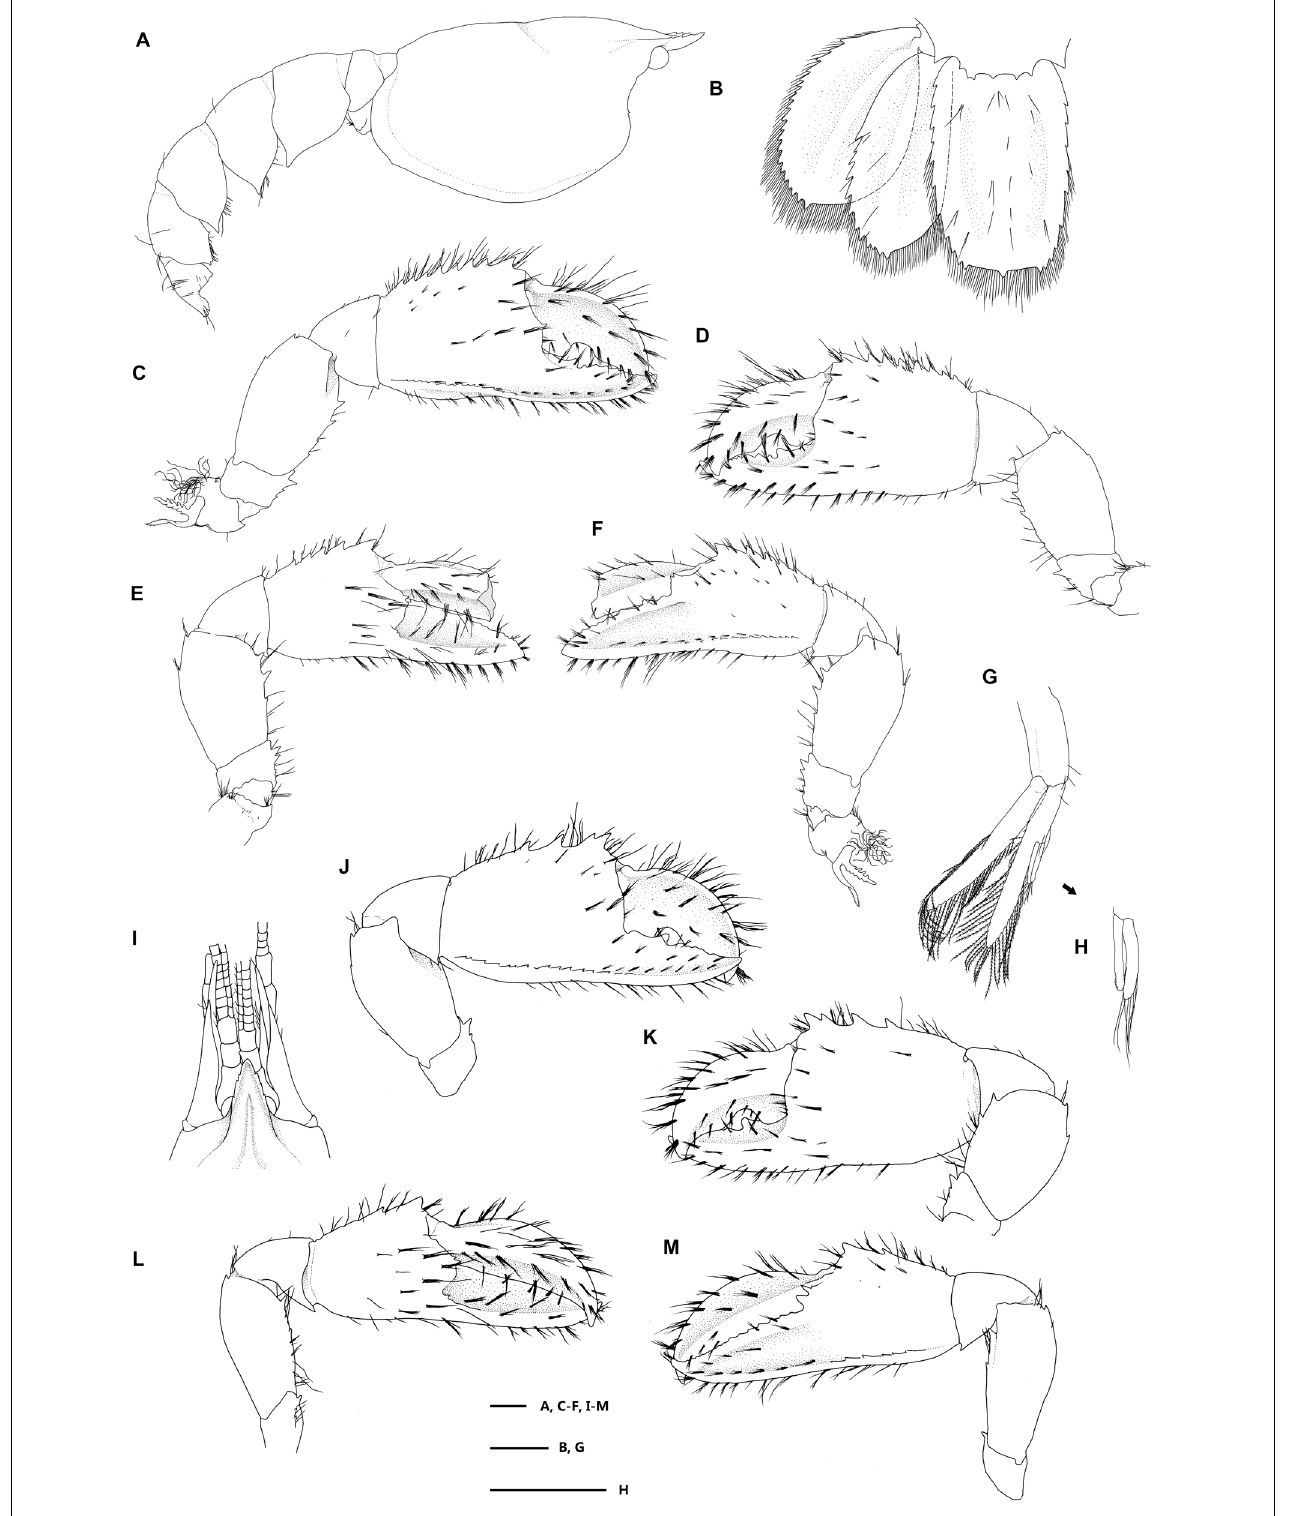
FIGURE 5 | Eiconaxius serratus sp. nov. Paratype, SRSIO 16040302 (male, cl 7.3 mm). (A) Carapace, pleon, lateral view; (B) pleomere 6, telson, left uropod, dorsal view; (C) major cheliped, right, lateral view; (D) same, inner view; (E) minor cheliped, left, inner view; (F) same, lateral view; (G) pleopod 2, left; (H) appendices interna and masculine, right. Paratype, SRSIO 16040301 (ovigerous female, cl 7.1 mm); (I) anterior carapace, antenna, antennule, dorsal view; (J) major cheliped, right, lateral view; (K) same, inner view; (L) minor cheliped, left, inner view; (M) same, lateral view. Scales: 1 mm.